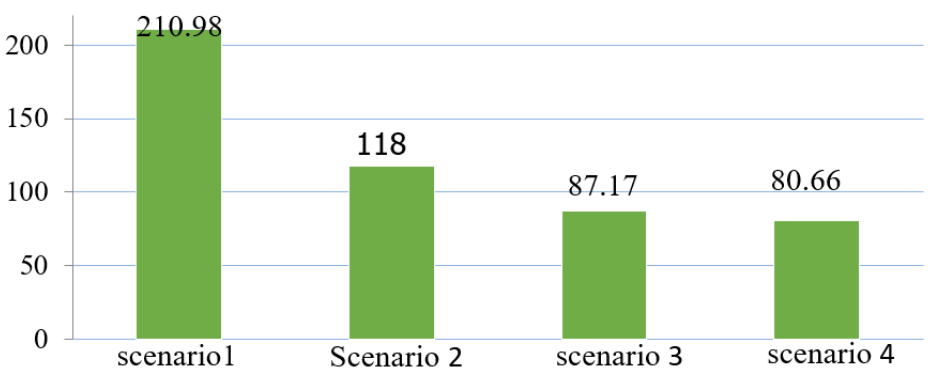
Figure 16. Power loss in the different scenarios. In the secondary simulations, for each of Scenarios 2, 3, and 4, three modes were pro- posed.